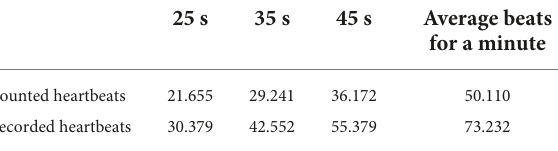
TABLE 1 Mean of the counted and recorded heartbeats and the average for a minute.